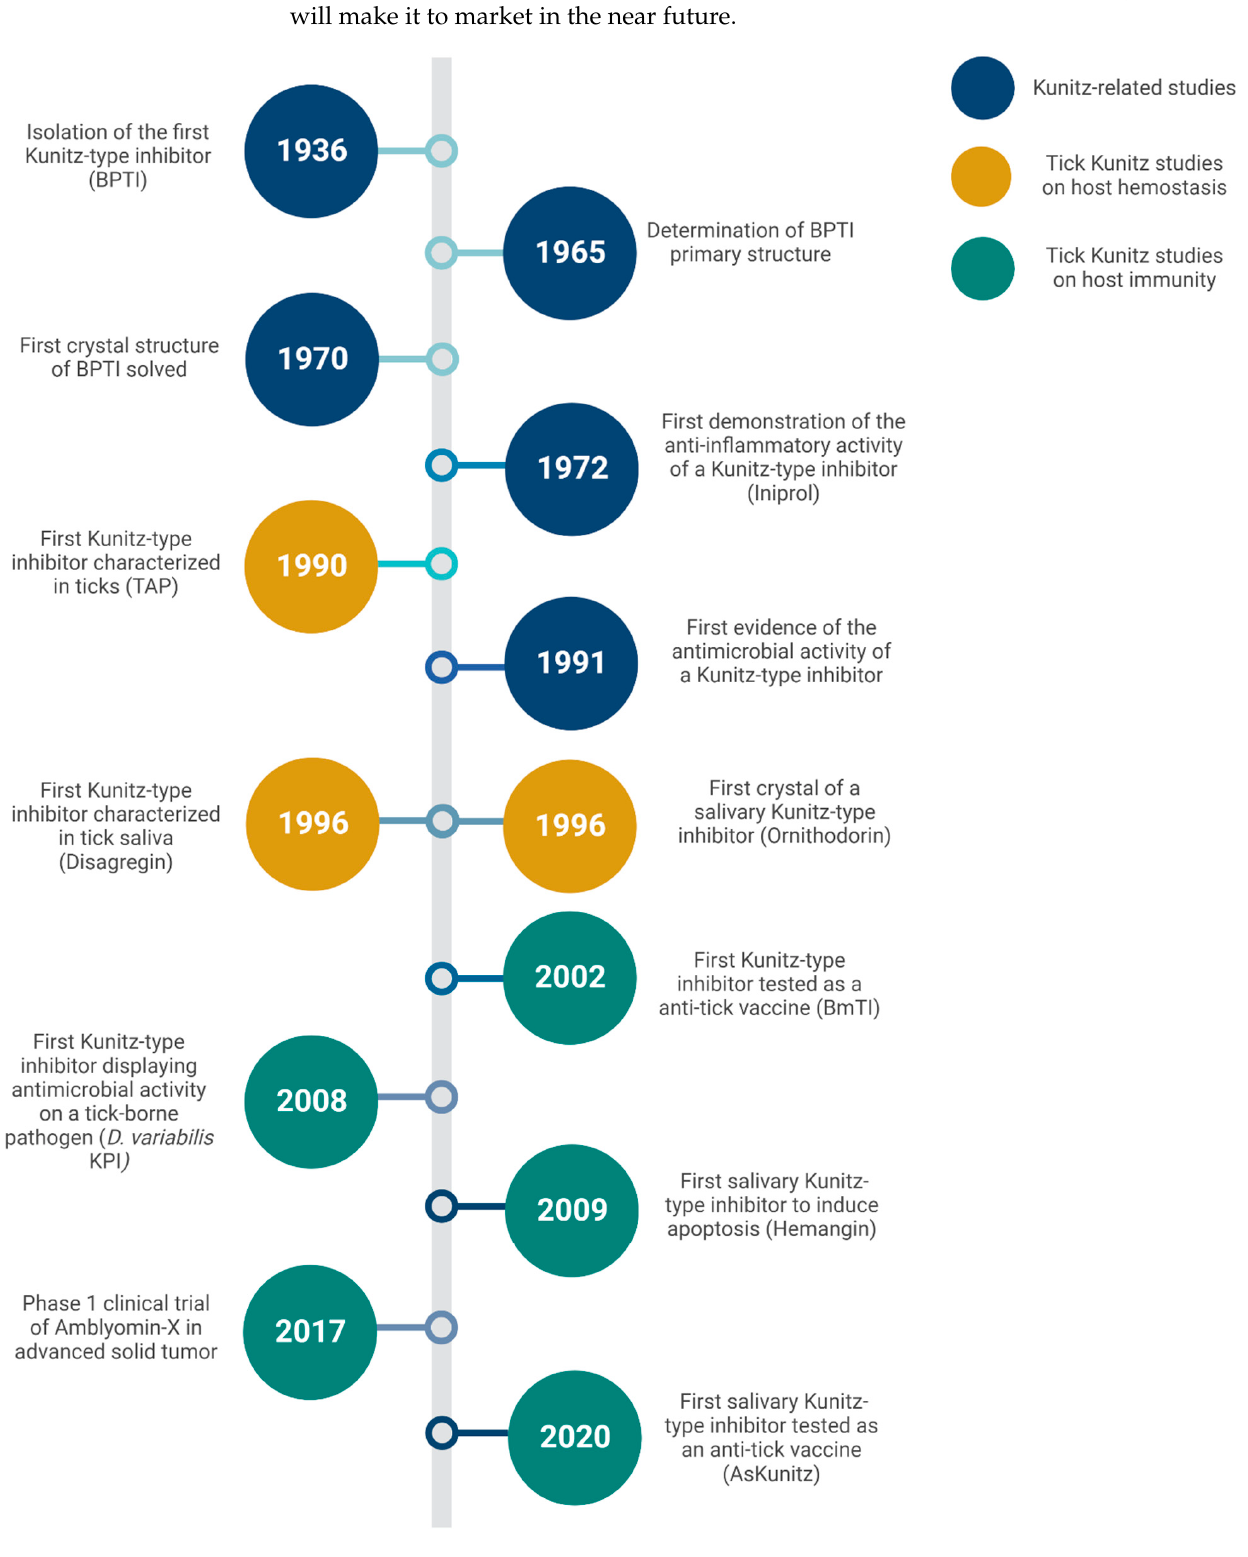
Figure 2. Discoveries and advances in Kunitz-type inhibitors since the uncovering of the family member and the major milestones in tick-derived species.